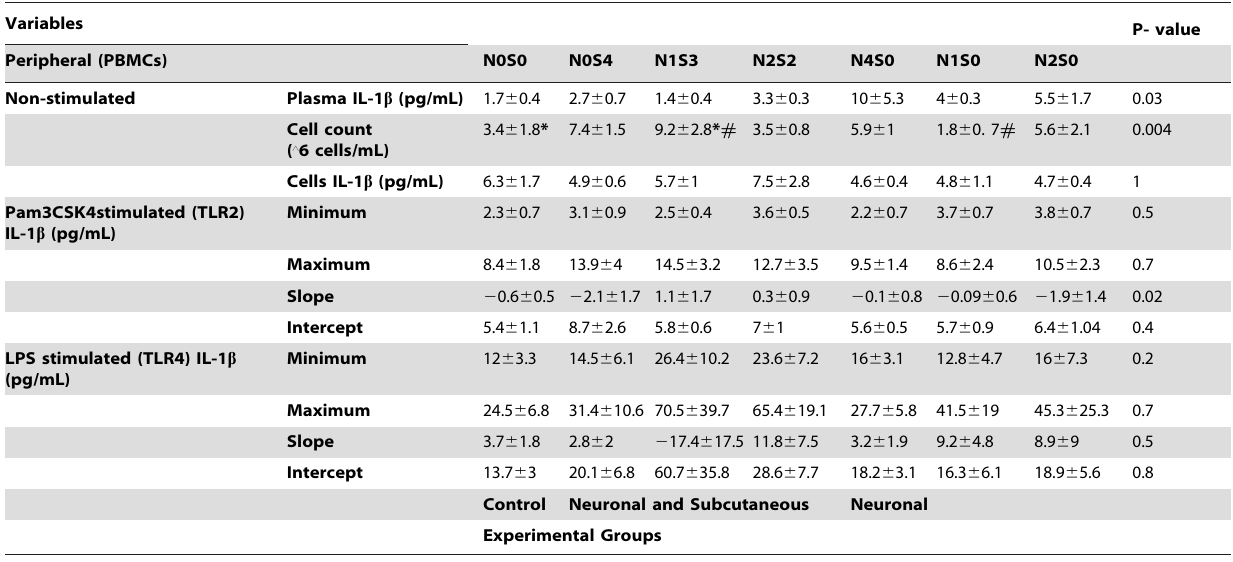
Table 1. Summary of variables collected from rats post CCI in the periphery region.